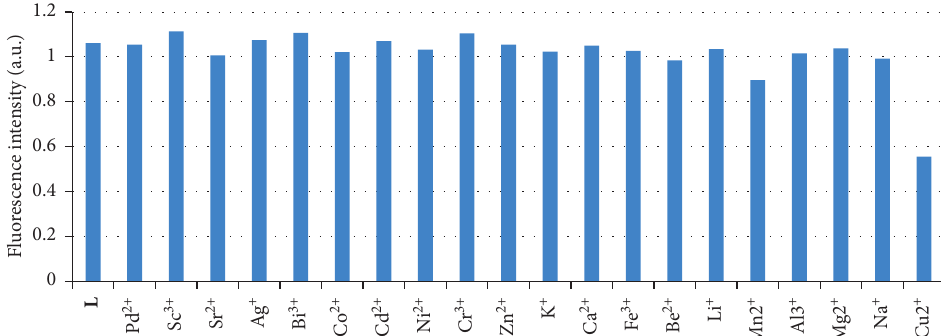
Figure 4: The fluorescence intensity at 360nm of L with the metal ions. L : 2.0 × 10 − 7 M; metal ion: 2.0 × 10 − 6 M.